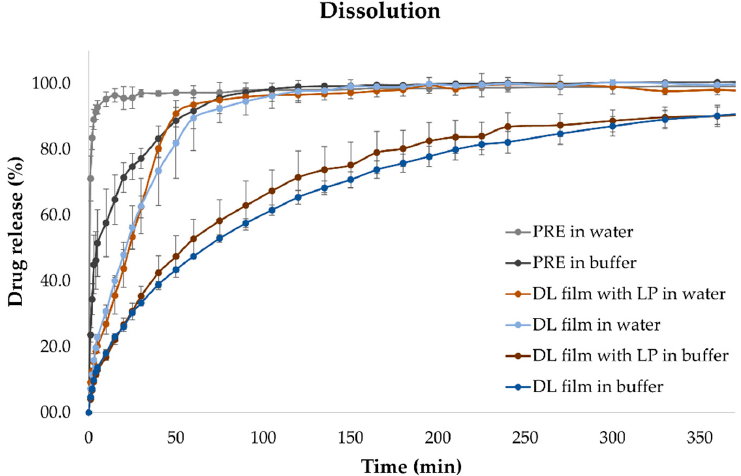
Figure 7. Drug release of pure substance and drug-loaded films with and without liver powder in phosphate buffer (pH 6.8) and in water. Average and standard deviations are shown, n = 3.